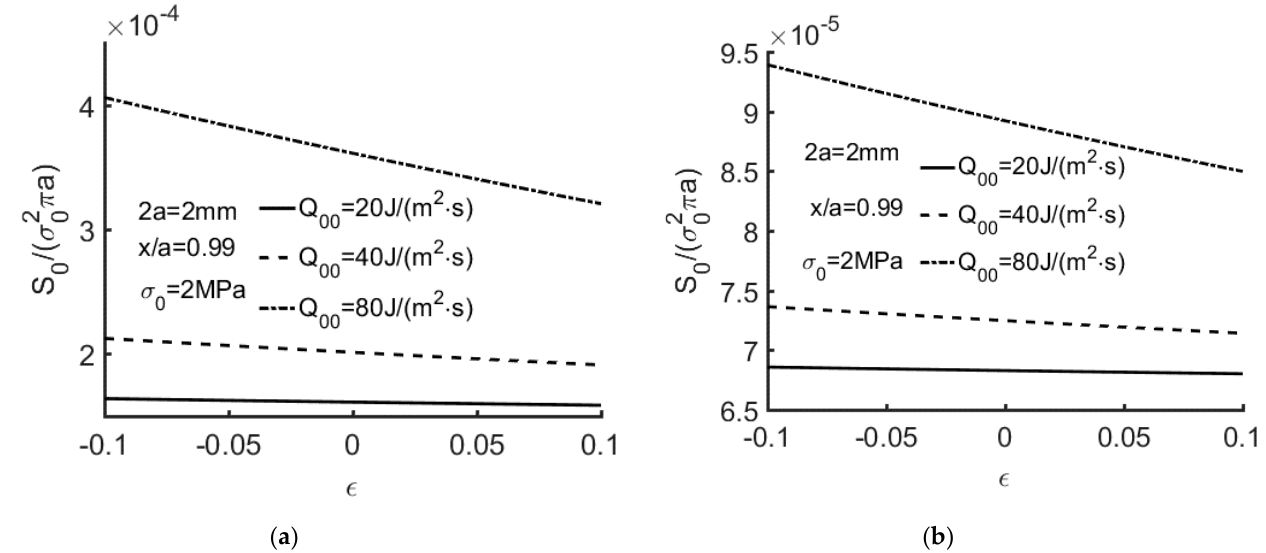
Figure 14. ( a ) S 0 /( σ 02 π a ) versus ε with Q 00 = 20, 40, 80 J/(m 2 · s) for E c = 1. (2 a = 2 mm, x/a = 0.99, σ 0 = 2 MPa). The orthotropic material listed in Table 1. ( b ) S 0 /( σ 02 π a ) versus ε with Q 00 = 20, 40, 80 J/(m 2 · s) for E c = 1. (2 a = 2 mm, x/a = 0.99, σ 0 = 2 MPa). The isotropic material listed in Table